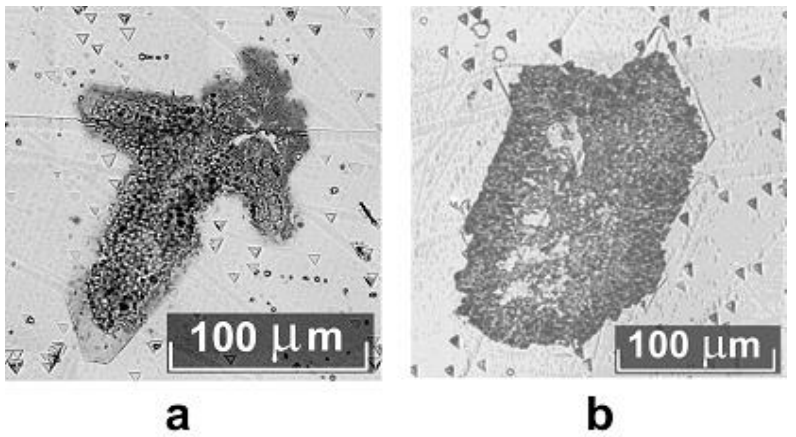
Figure 10. The second phase with incoherent boundaries formed in a crystal LiNbO 3 :Zn ([ZnO] ≈ 3.95 mol.% in a crystal). Z-cut.